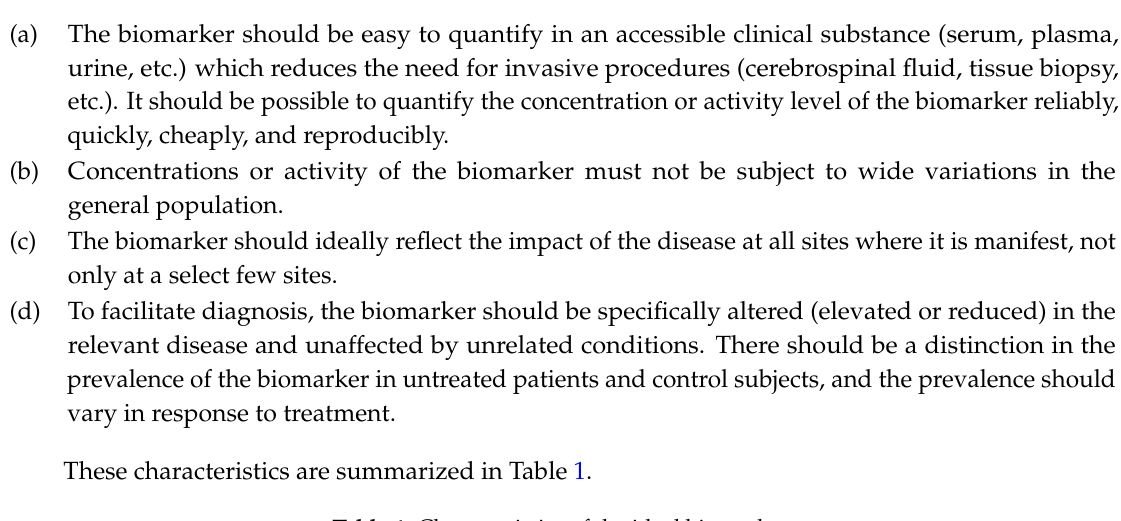
Table 1. Characteristics of the ideal